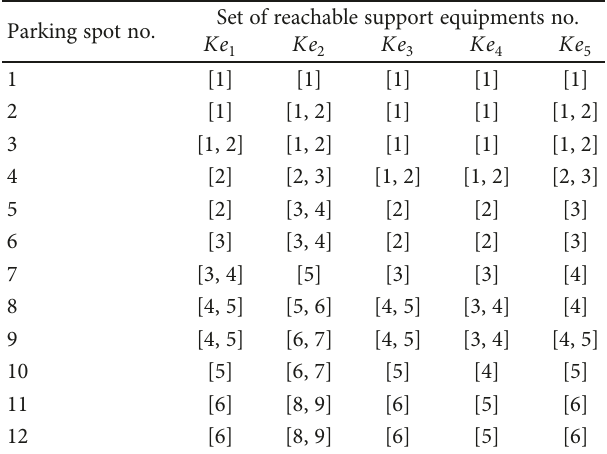
Table 9: Reachability relation between parking spots and support equipments. Parking spot